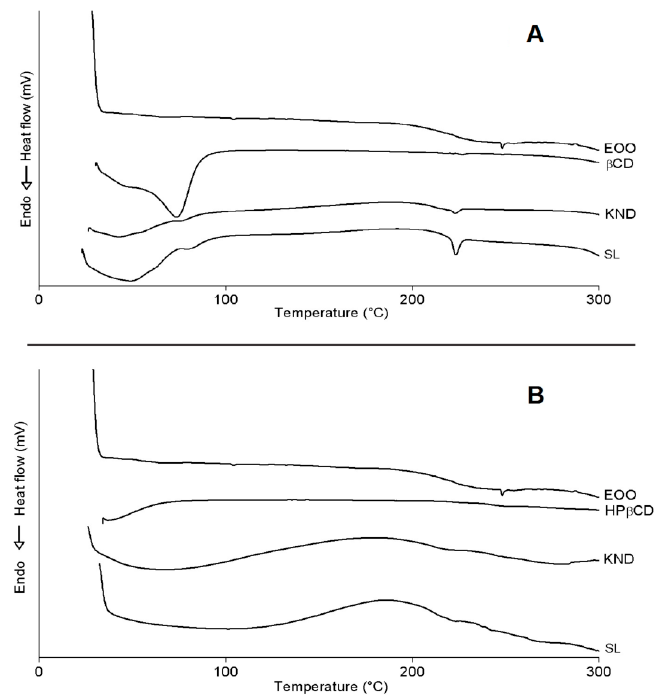
Figure 6. DSC curves of E. oleracea oil (EOO), β -cyclodextrin ( β -CD) and EOO- β -cyclodextrin inclusion complexes prepared by kneading (KND) and slurry (SL) ( A ). DSC curves of EOO, hydroxy-propyl- β - cyclodextrin (HP- β -CD) and EOO-hydroxy-propyl- β -cyclodextrin inclusion complexes prepared by KND and SL ( B